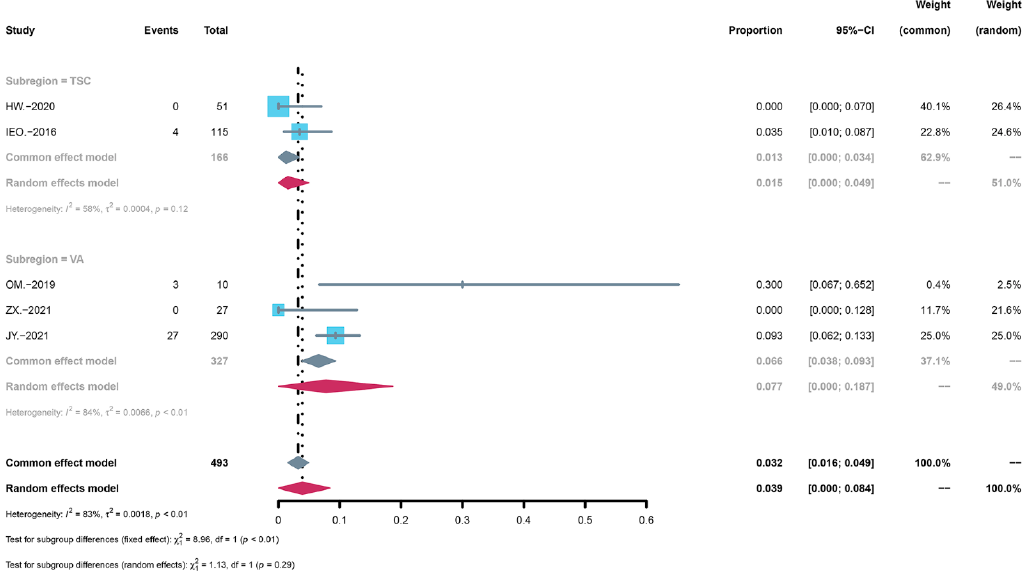
Figure 4. Forest map of the concentration subgroup analysis of serious adverse events.